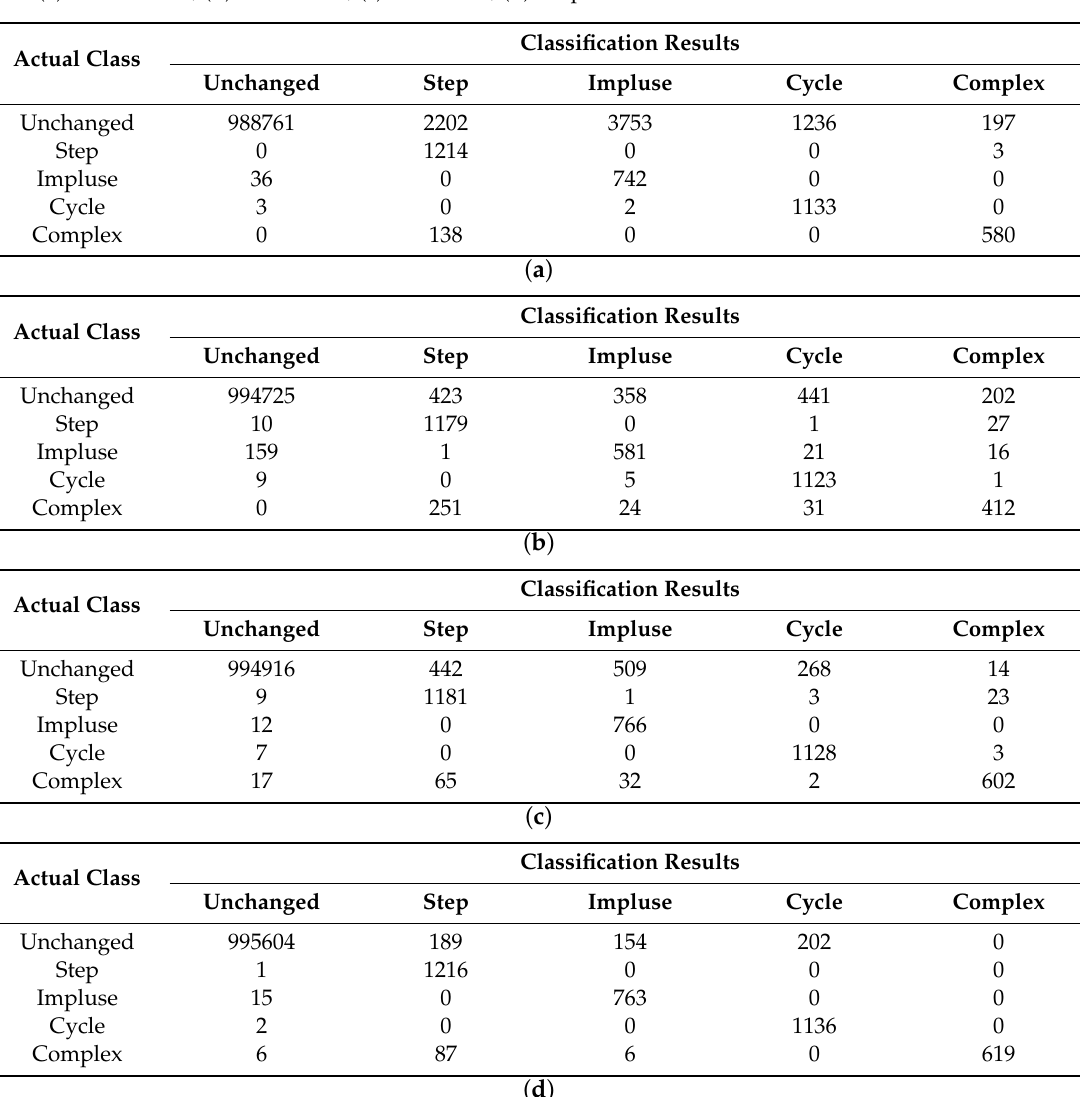
Table 3. The multi-class confusion matrix of di ff erent classification results using synthetic